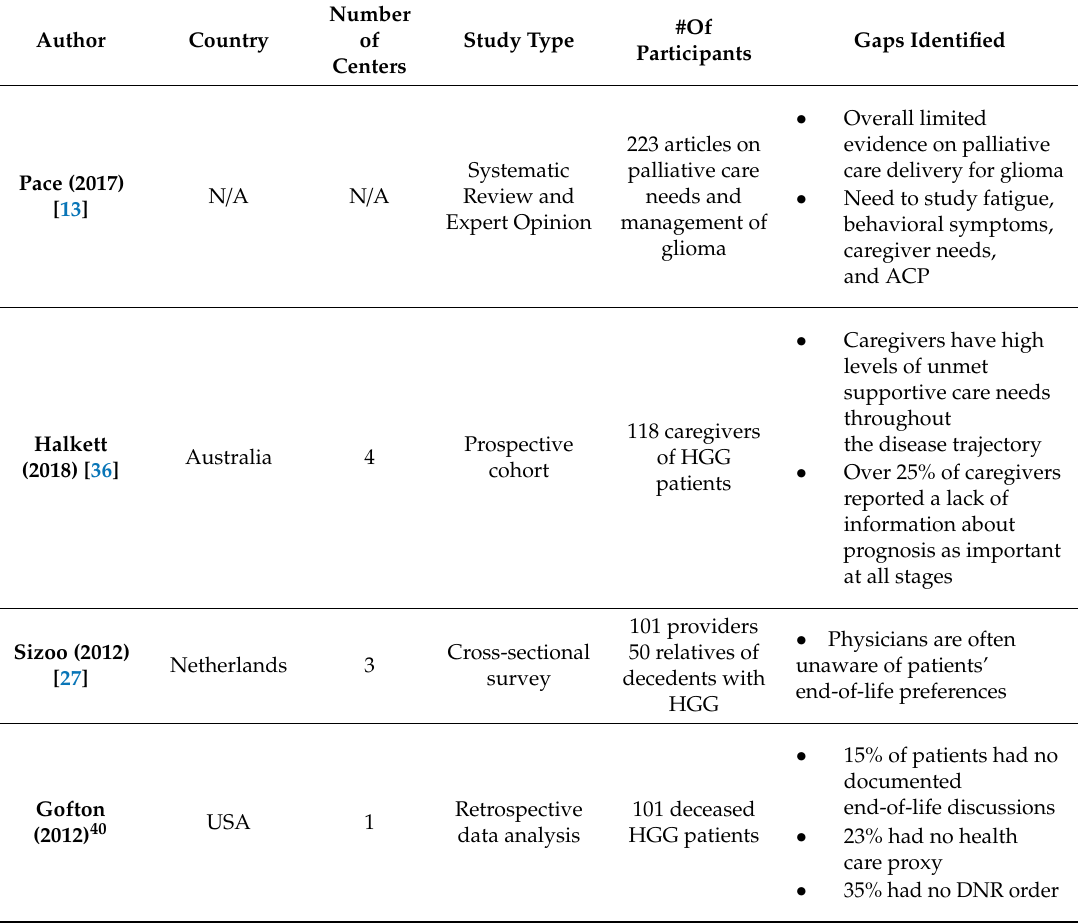
Summary of the literature on unmet palliative care needs among patients with high-grade